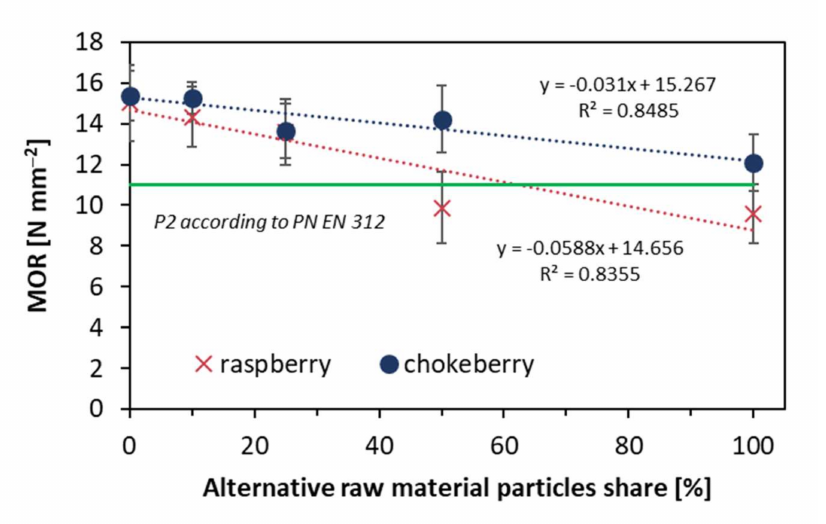
Figure 5. Modulus of rupture of the tested